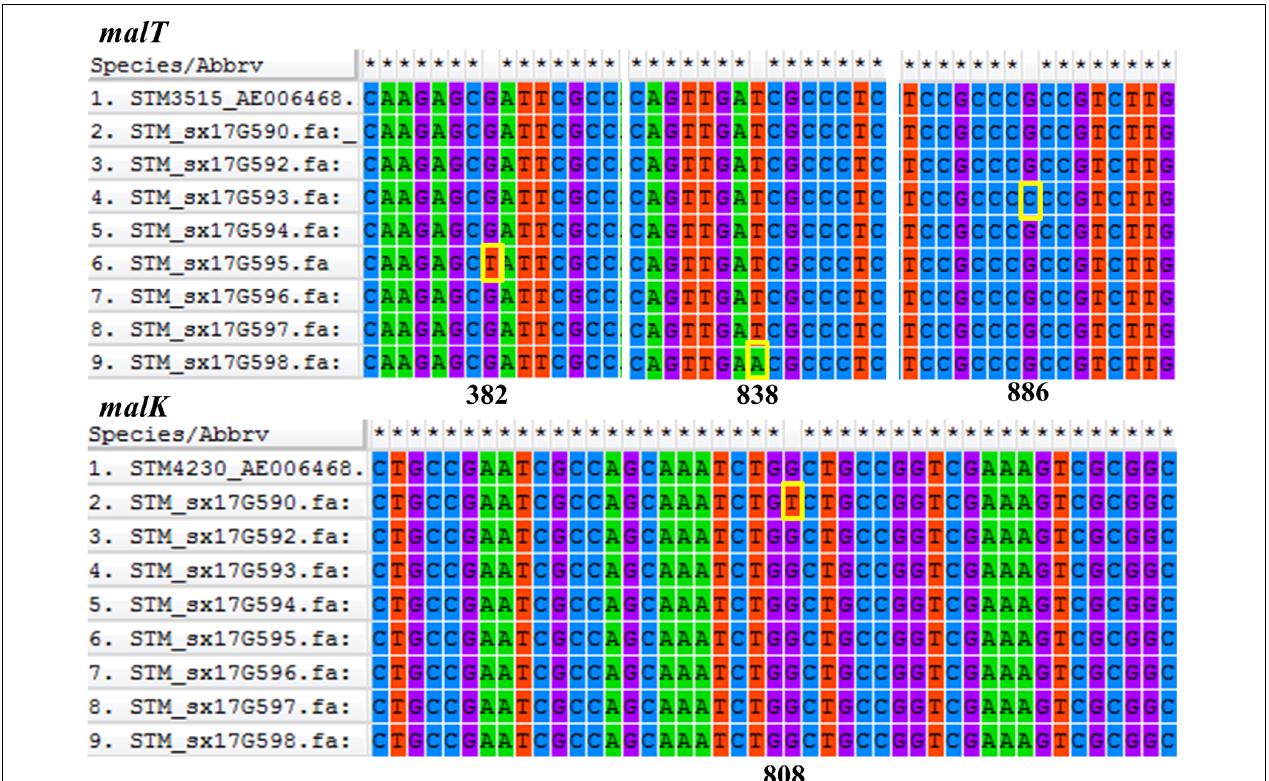
FIGURE 3 | Comparative analysis of the malT and malK genes. Gene sequences were aligned and visualized using MEGA6 software. Position of each gene sequence of outbreak strains was compared to the ASM694v2 reference genome of S . Typhimurium shown in the first row of each alignment. The mutation sites of the outbreak strains were marked with yellow